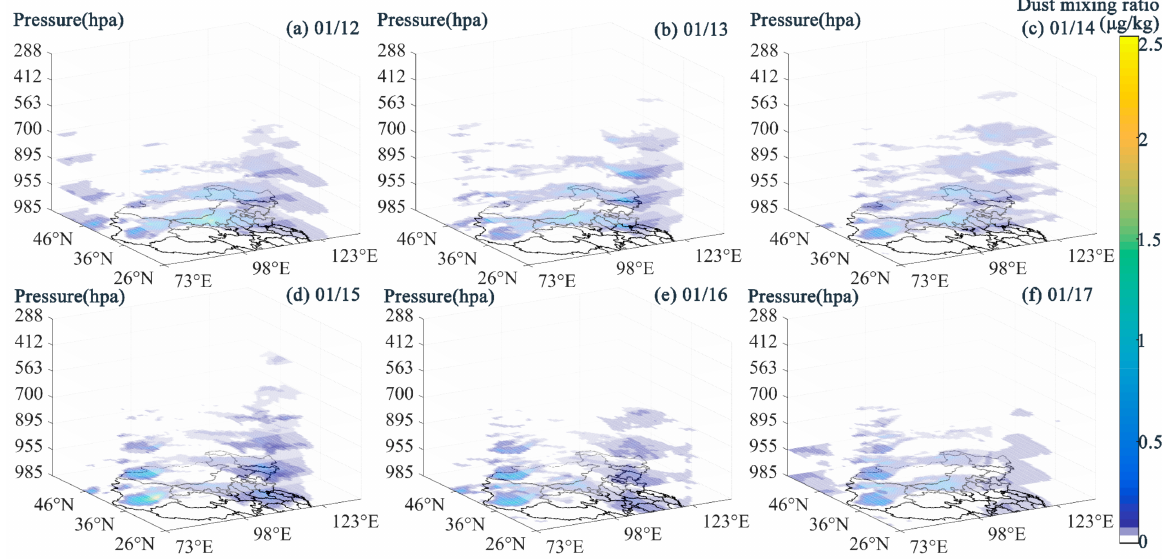
Figure 4. MERRA-2 dust mixing ratio during the 1.12 event.